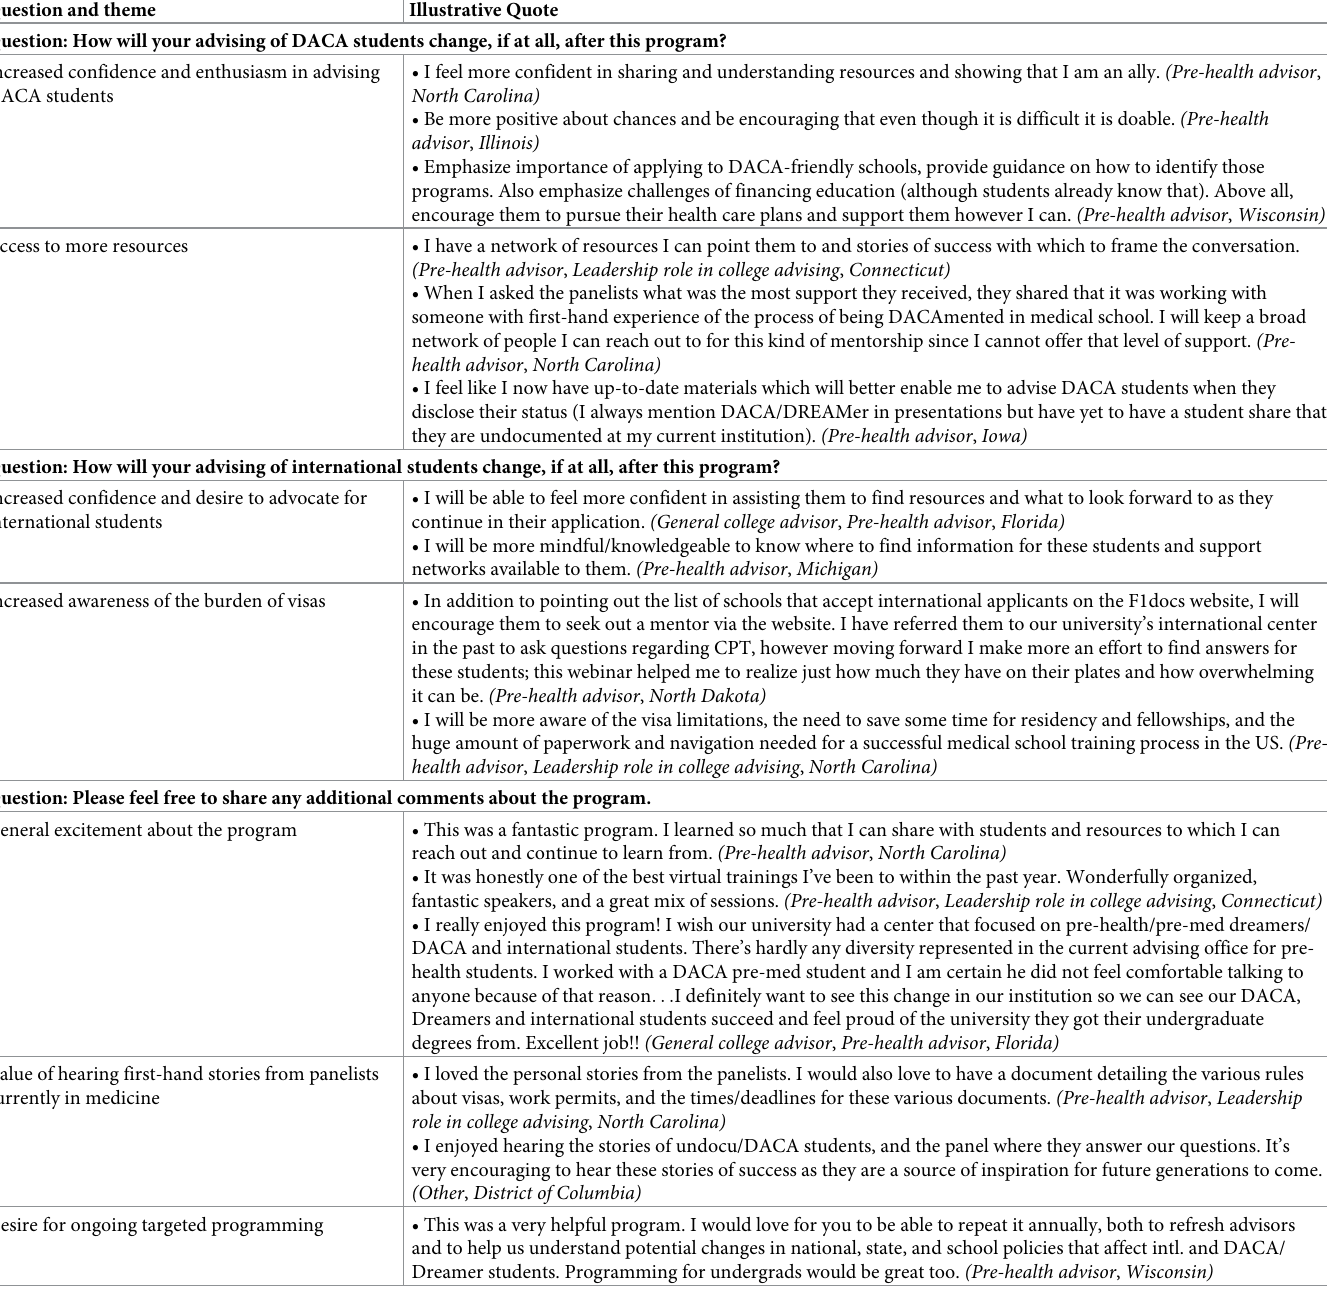
Table 3. Thematic analysis of open-ended survey responses evaluating program on supporting students with DACA and international visas in medicine program, July 2021. Question and